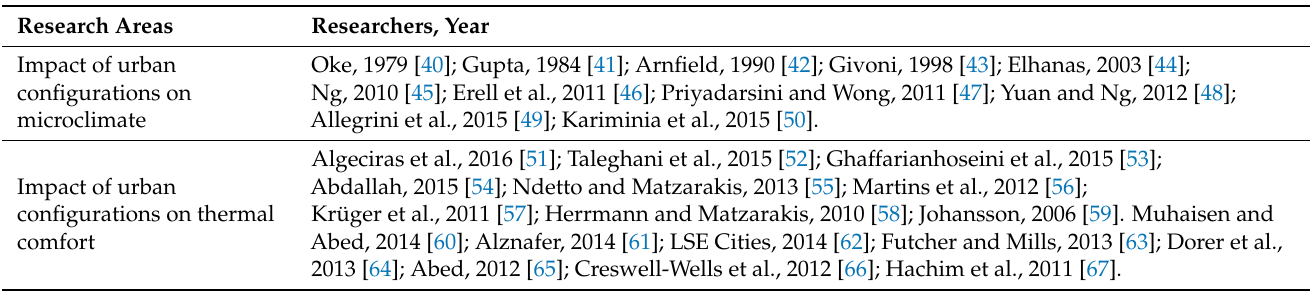
Table 1. Studies on the impact of urban configurations on microclimate and thermal